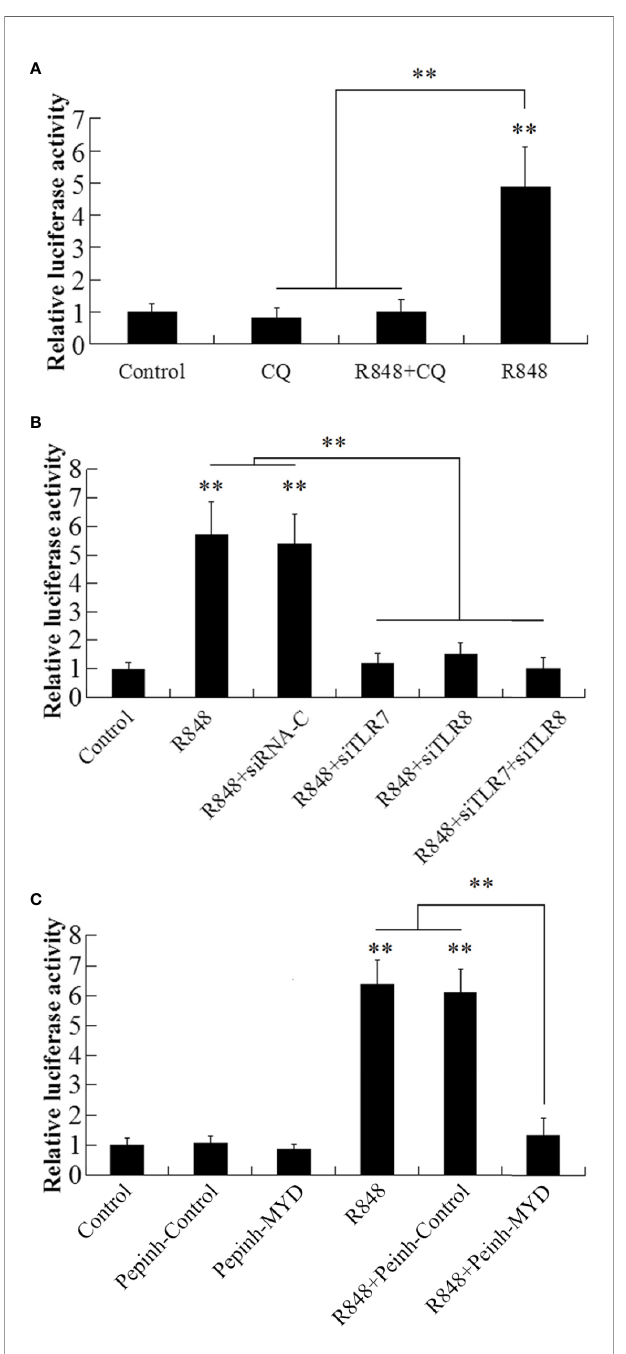
FIGURE 5 | Effect of R848 on NF- k B activity. GPS cells containing NF- k B- RE- luc2P reporter were treated with or without (control) R848, chloroquine (CQ), or R848 plus CQ and then analyzed for luciferase activity (A) . GPS cells containing NF- k B-RE- luc2P reporter were transfected with siTLR7, siTLR8, siTLR7 plus siTLR8, siRNA-C, or PBS (control) and then treated with R848. The luciferase activity in the cells was then determined (B) . GPS cells containing NF- k B-RE- luc2P reporter were treated with R848 in the presence or absence of Pepinh-Control or Pepinh-MYD; the control cells were treated with PBS. The luciferase activity in the cells was then determined (C) . Data are expressed as means ± SEM (N = 3). N, the number of times the experiment was performed. **P < 0.01.